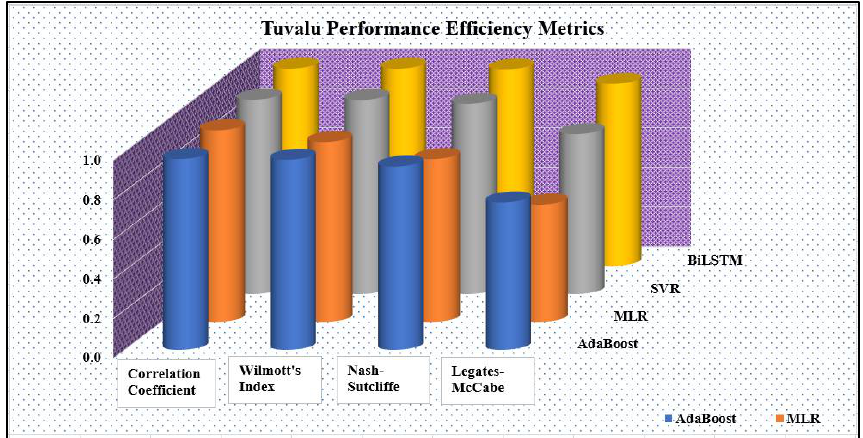
Figure 14. Bar chart of model performance for Tuvalu.